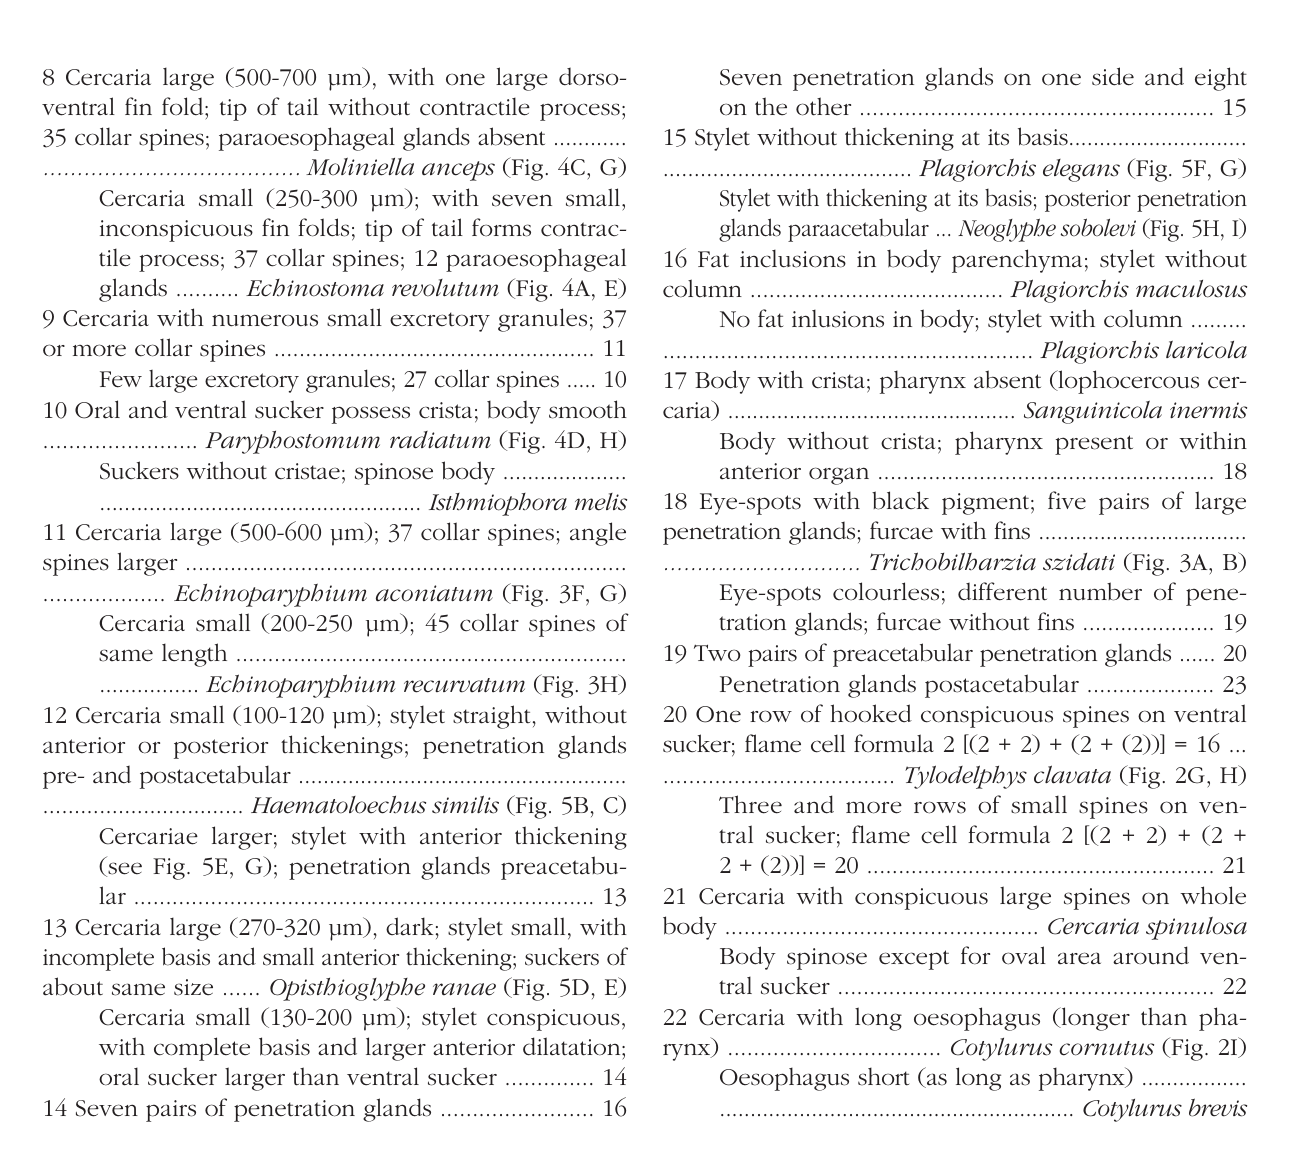
Table II. – Survey of species of cercariae reported from Lymnaea stagnalis in Europe.